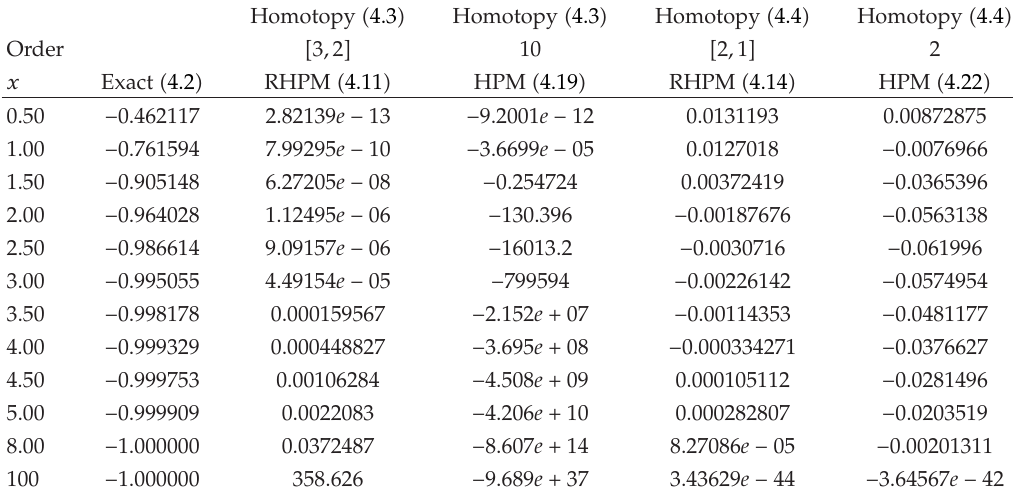
Table 1: Comparison of the relative error between exact solution (cid:3) 4.2 (cid:4) for (cid:3) 4.1 (cid:4) to the results